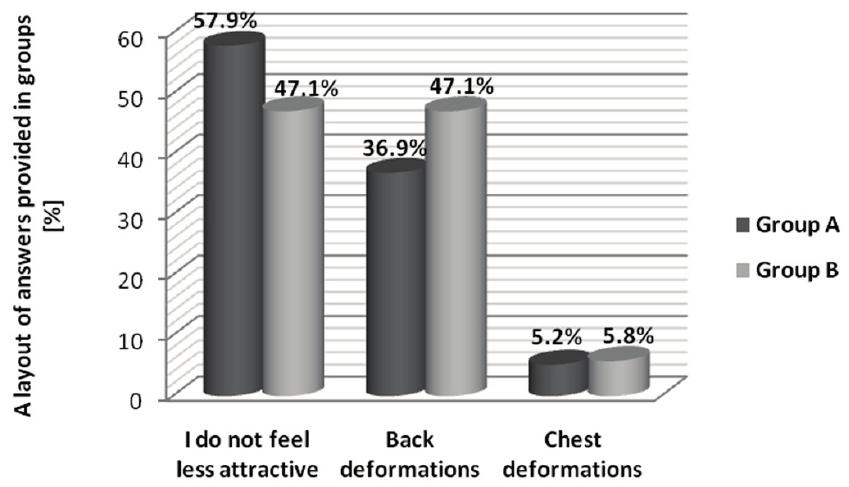
Figure 1. A representation of answers provided in